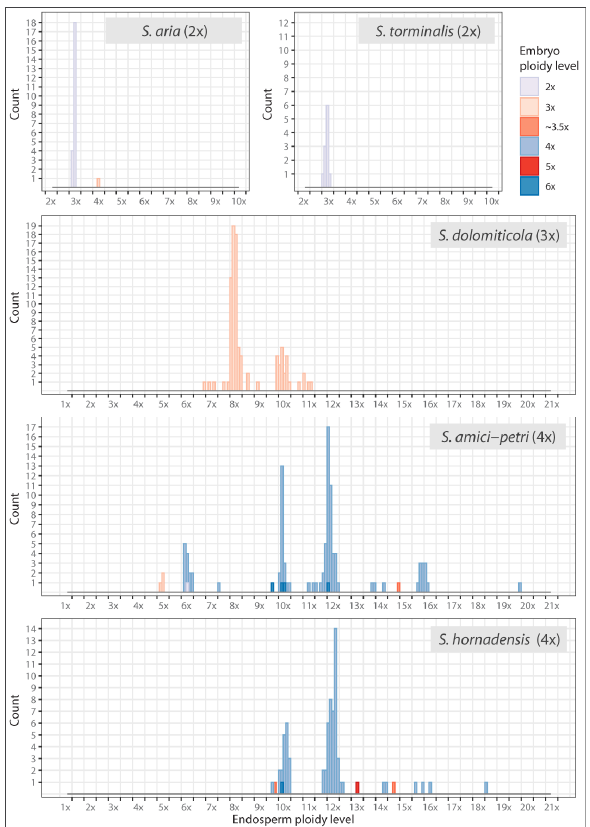
Figure 6. Calculated endosperm ploidy levels of 305 seeds of Sorbus analyzed in the present study. The estimated euploid and aneuploid ploidy level categories are separated by vertical lines. The embryo ploidy level associated with endosperm is depicted using sequential and qualitative coloring for increasing ploidy level and for even vs. odd ploidy, respectively.